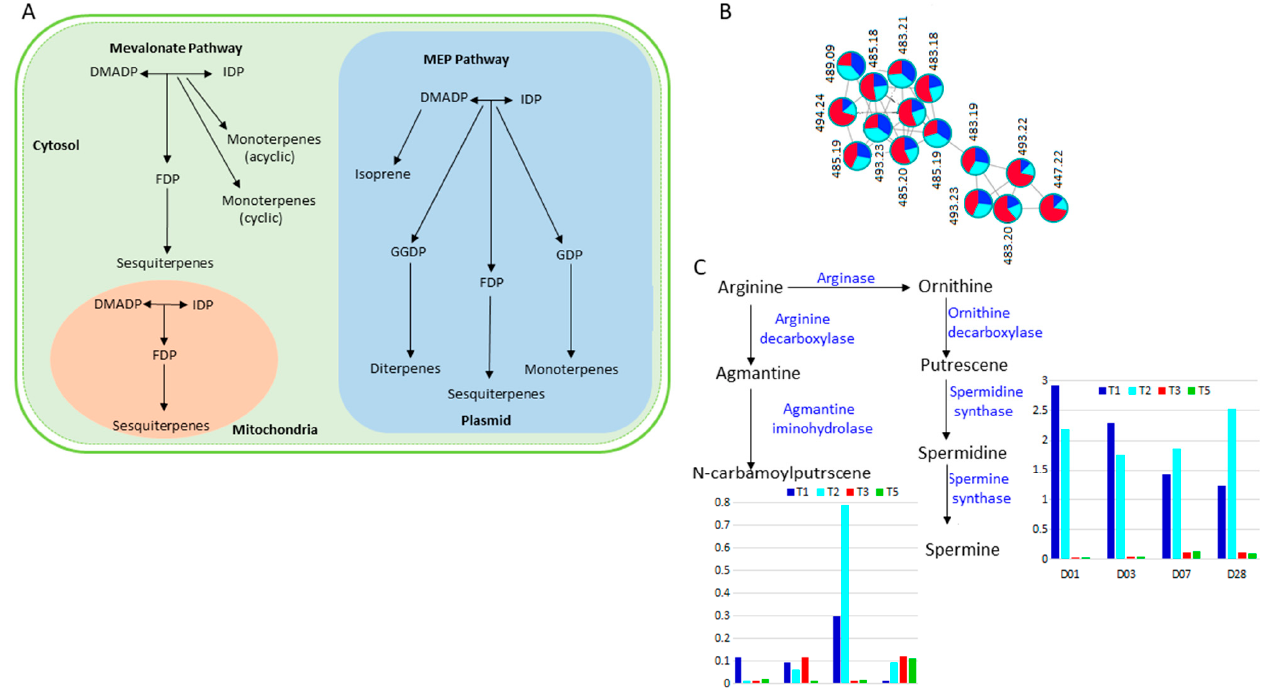
Figure 8. Changes in metabolism of terpenes and polyamines in response to salt stress and Si-biostimulant treatment. ( A ) A simplified representation of two main terpenes’ biosynthesis pathways: mevalonate pathway, which takes place in the cytosol (green) and the mitochondria (brown), and the 2-C-methyl-D-erythritol-4-phosphate (MEP) pathway which occurs in the plasmid (blue). ( B ) The relative abundance of the measured terpenes across non-stressed controls (dark blue), salt stressed (light blue) and Si treated plants (red) is presented as pie charts of the molecular network cluster of terpenes and derivatives (see Figure 1). ( C ) An outline of polyamine synthesis pathways and corresponding graphs showing levels of spermidine and spermine across stressed controls (T1), salt stressed (T2) and Si treated plants (T3 and T5) at all time points. Abbreviations: DMADP, dimethylallyl diphosphate; MEP pathway, 2-C-methyl-D-erythritol 4-phosphate pathway; IDP, isopentenyl diphosphate; FDP, farnesyl diphosphate; GDP, geranyl diphosphate; GGDP, geranylgeranyl